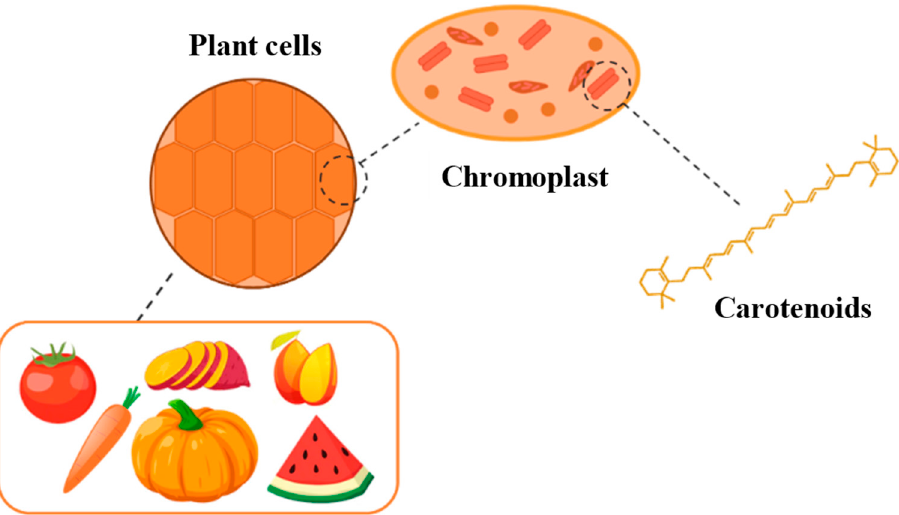
Figure 1. Schematic representation of the main sources and chromoplast structures containing ca ‐ rotenoids.